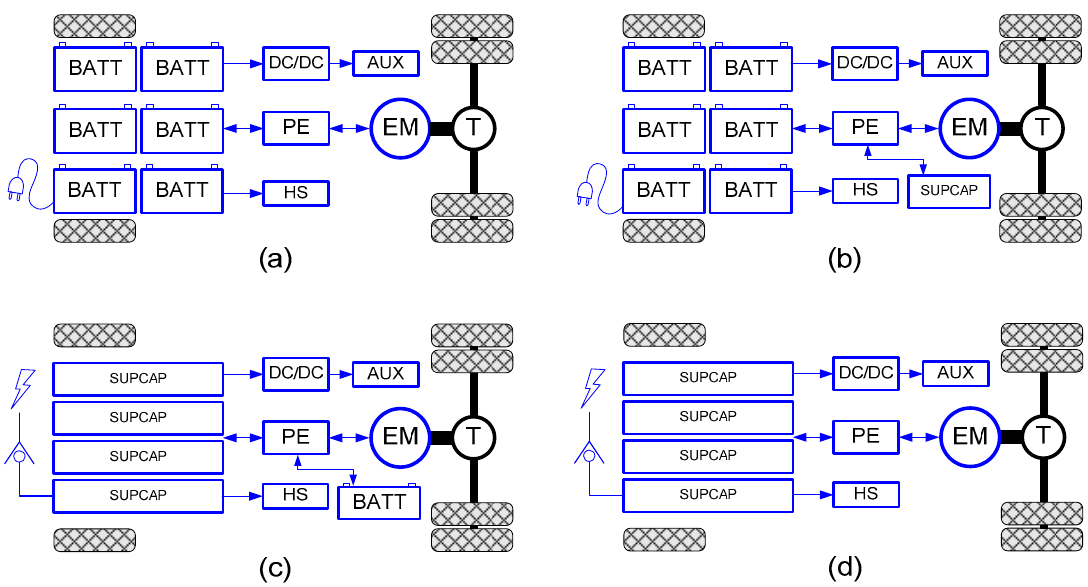
Figure 1. Drive system configurations in tested electric buses: ( a ) layout with a large battery pack, ( b ) battery system with a small bank of supercapacitors, ( c ) layout with a supercapacitor bank and a small battery pack, ( d ) layout with a large bank of supercapacitors. BATT—Battery Pack; EM—Electric Motor; PE—Power Electronics; DC/DC—DC/DC Converter; AUX—Auxiliary and On-board Equipment; HS—Heating System; T—Transmission.